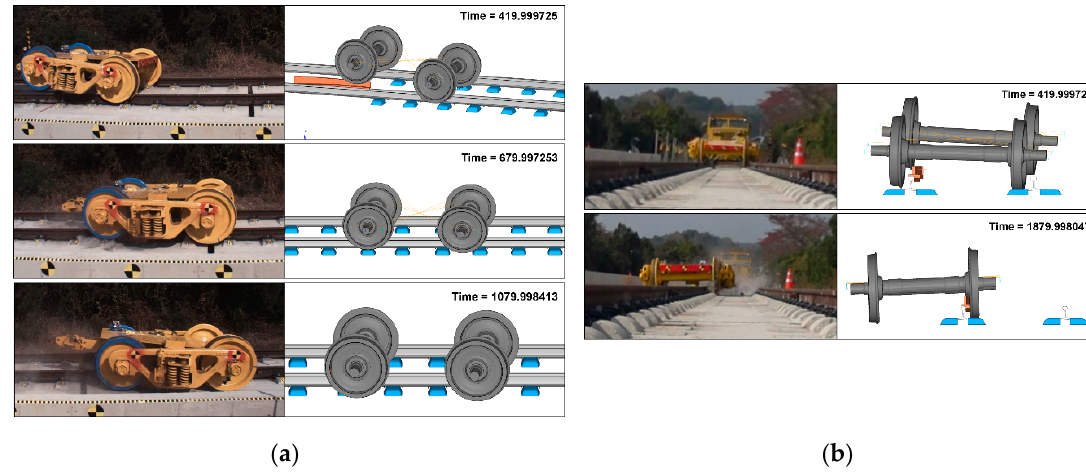
Figure 10. Derailment behaviors. ( a ) Derailment behavior (Side view); ( b ) Derailment behavior (Front view)